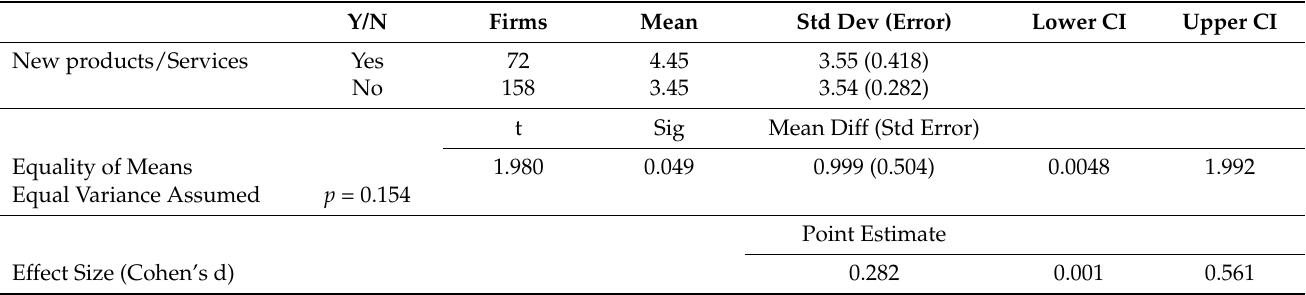
Table 3. New Product (Service) Launch Effect on Loan Amount